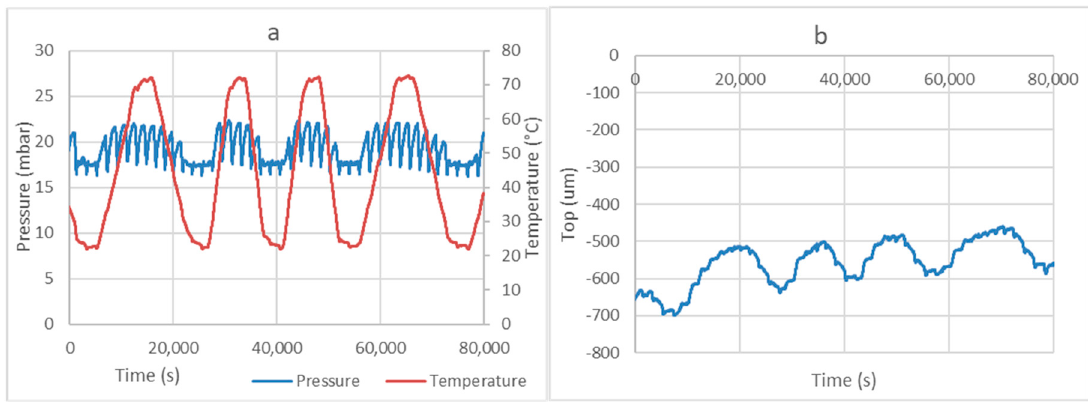
Figure 5. Example of a desorption–adsorption process with 20 g of MgSO4 with the evaporator at 15 °C ( a ). Diagram ( b ) represents the evolution of the position of the liquid surface in the evaporator, where “Top” is the position of the fluid surface with respect to the 0 point of the laser sensor.